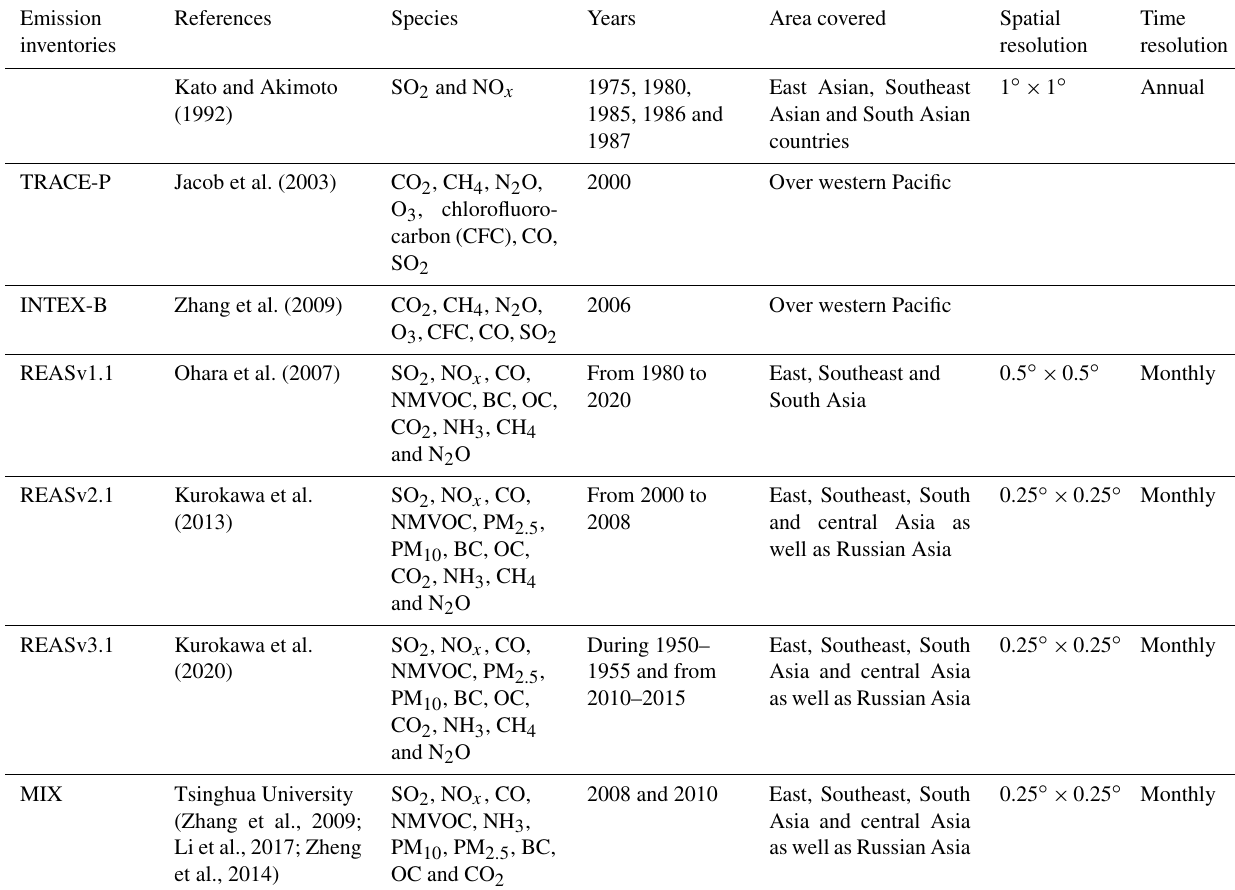
Table 1. General information on Asia emission inventories.